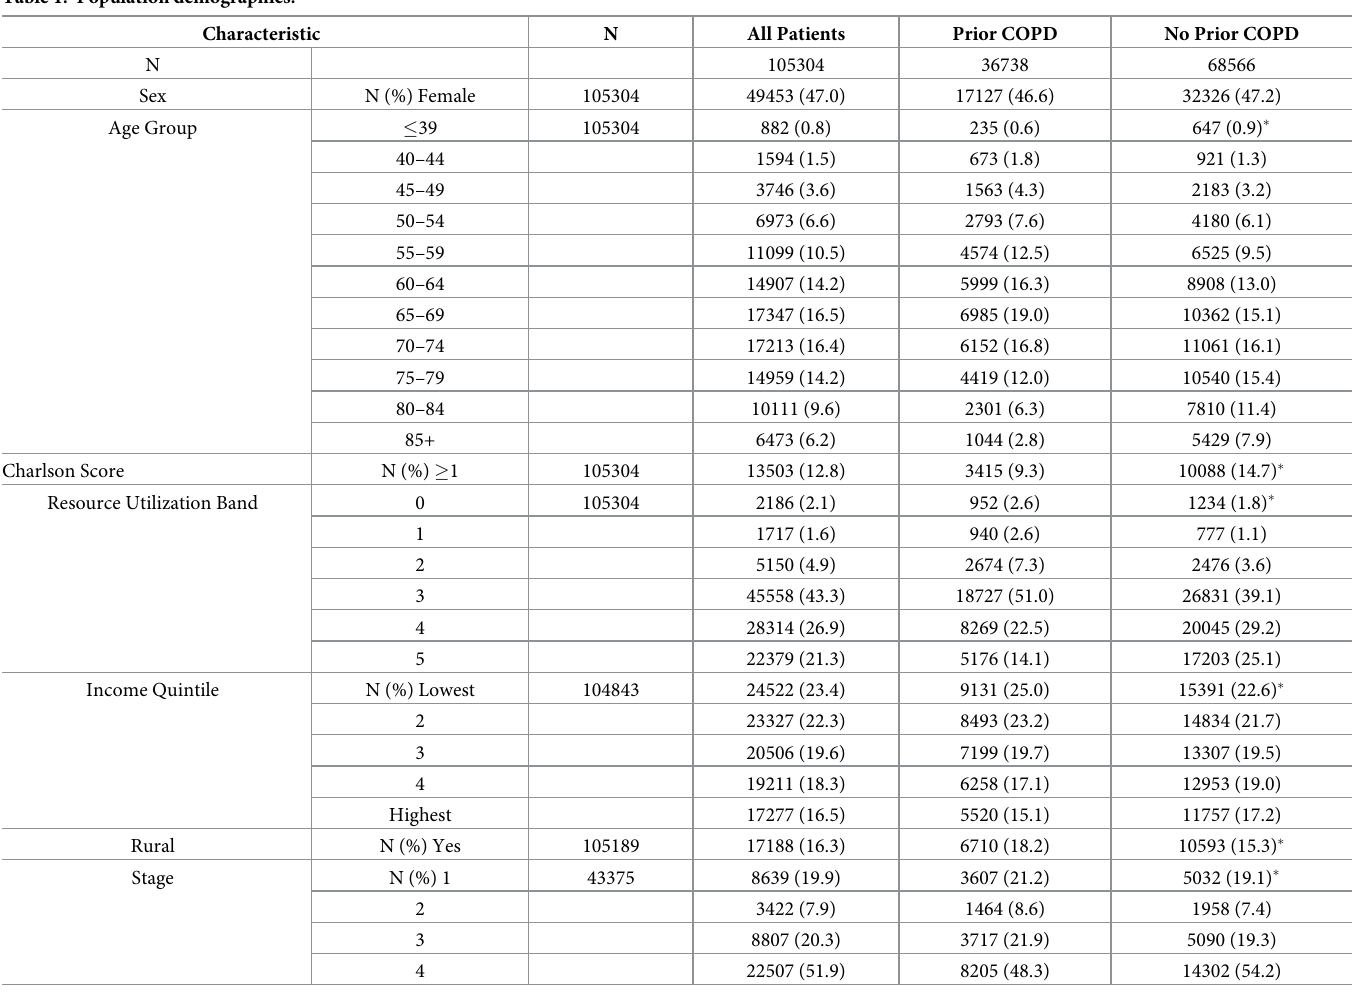
Table 1. Population